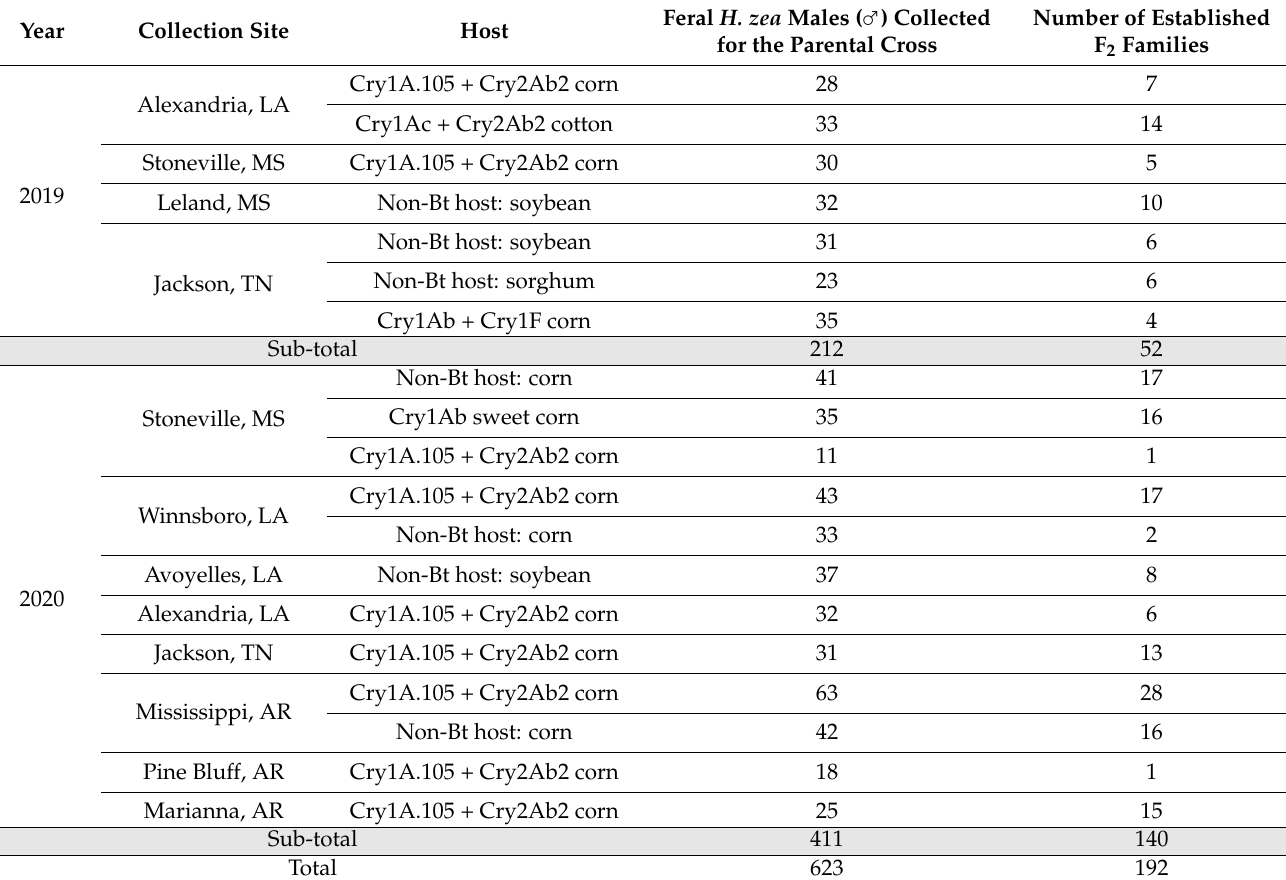
Table 1. Success of establishing F 2 families of Helicoverpa zea using a feral male moth mating with susceptible female